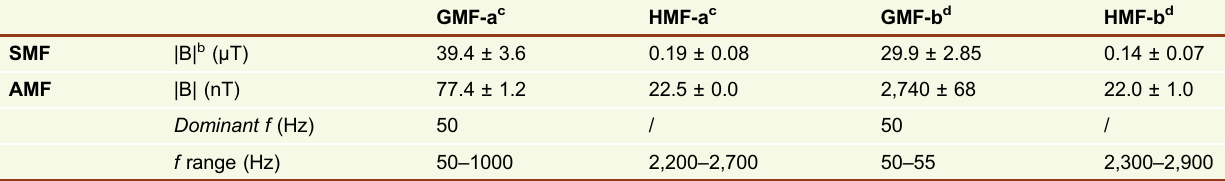
a Data were shown as mean ± s.d. b The vector sum of the magnetic fi eld in three directions. c The HMF system for cell culture.